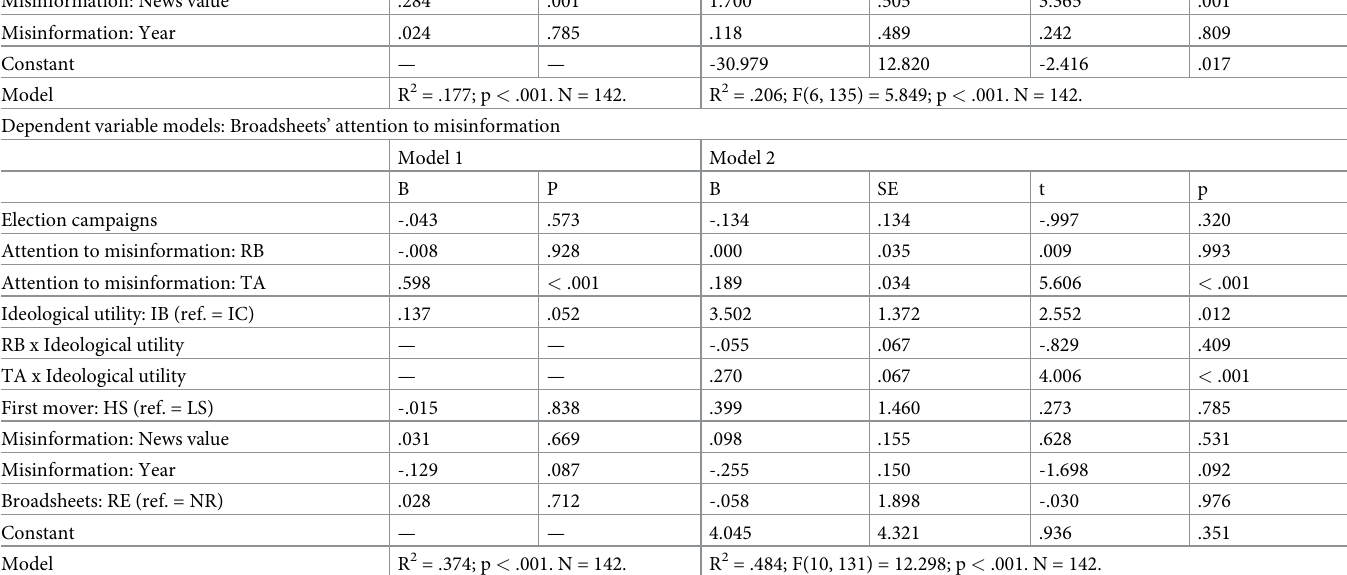
(Table 5). Accordingly, H3a is supported. However, in the case of business journalism (Table 6), neither tabloids’ ( β = .140, p = .189) nor rival broadsheets’ ( β = .136, p = .182) atten- tion to misinformation has a significant effect–at least across both levels of ideological utility. H3b is, therefore, not supported. Furthermore, the ideological utility of political misinformation significantly and positively moderates the relationship between tabloids’ and broadsheets’ attention to political misinfor- mation ( B = .270, t (131) = 4.006, p < .001) (Table 5). However, the ideological utility doesn’t